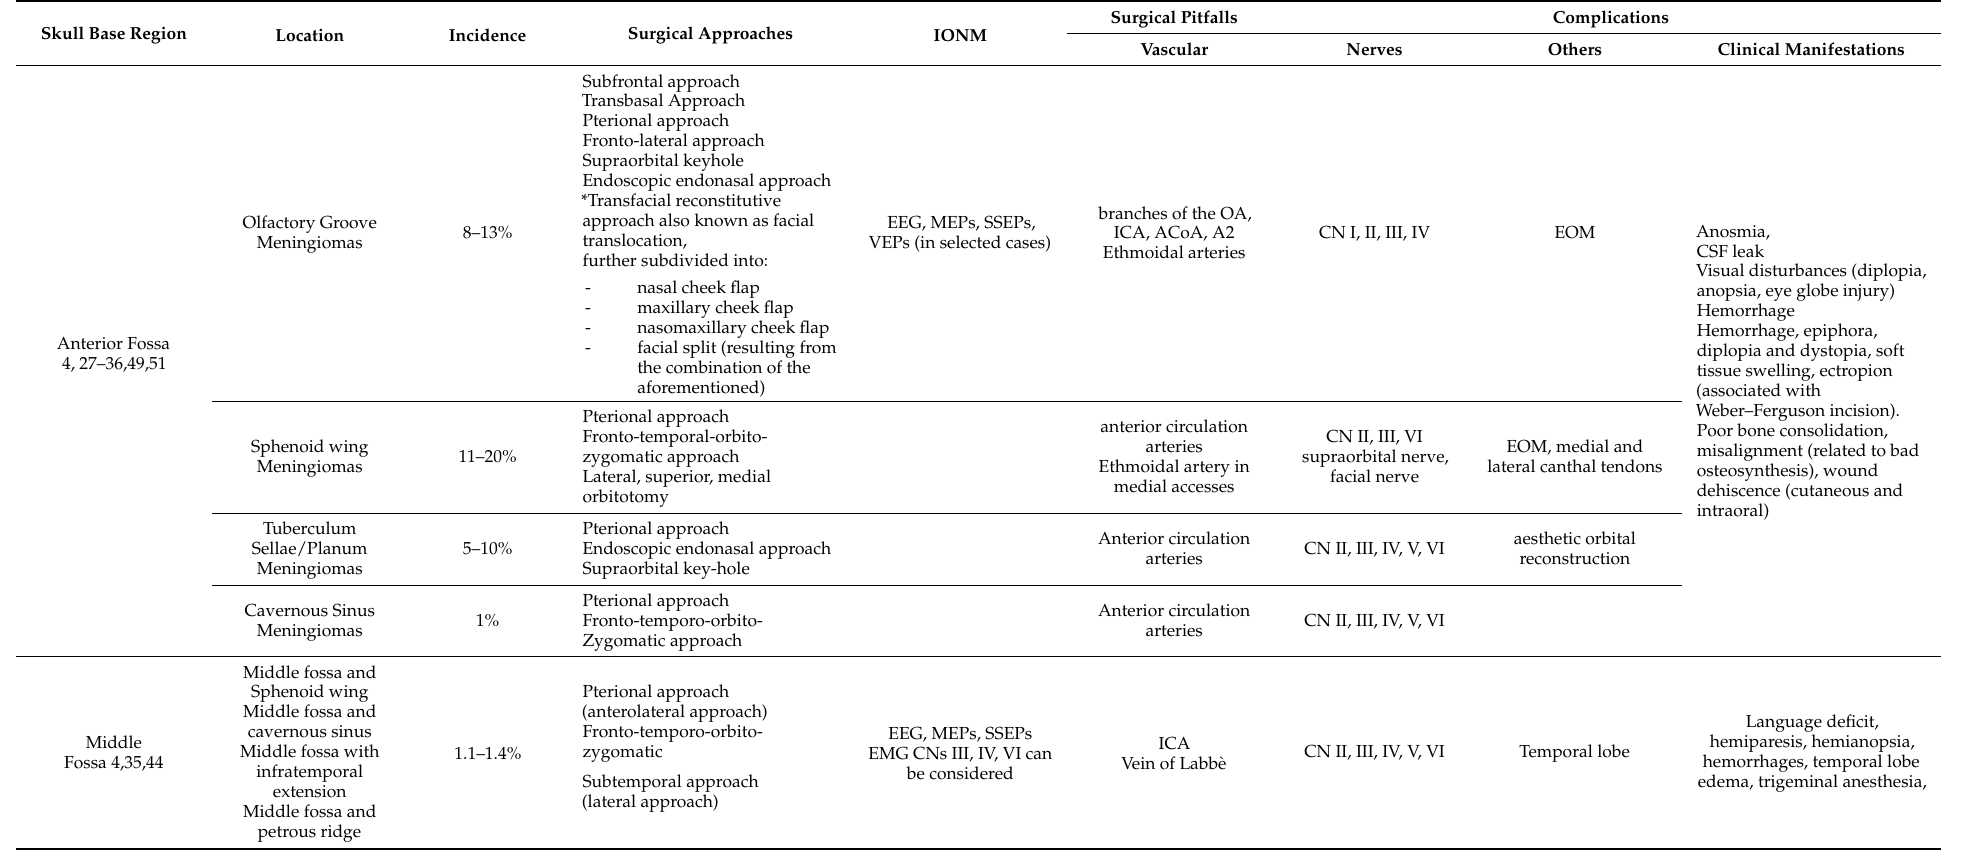
Table 1. Literature review of surgical approaches according to SBMs location. Surgical approach is selected by interdisciplinary consultation according to the site of disease. Skull Base